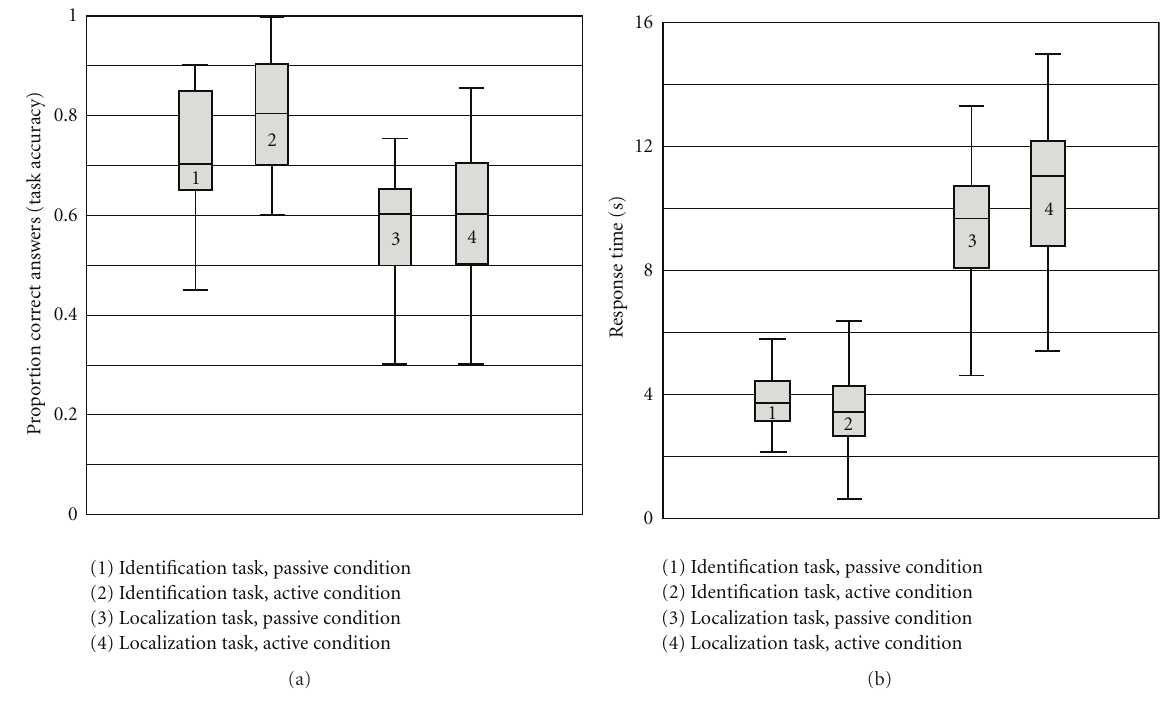
Figure 3: Boxplots show median, interquartile range, and extreme values of both the accuracy and latency scores, for each group and test. Table 1: Analysis of covariance results for post test accuracy (single